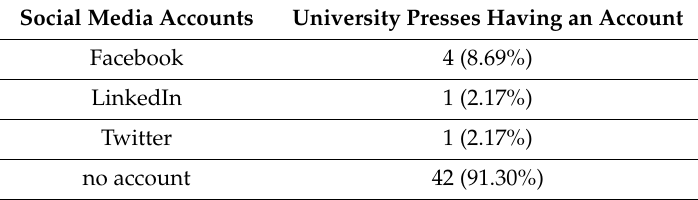
Table 4. Presence in social media.